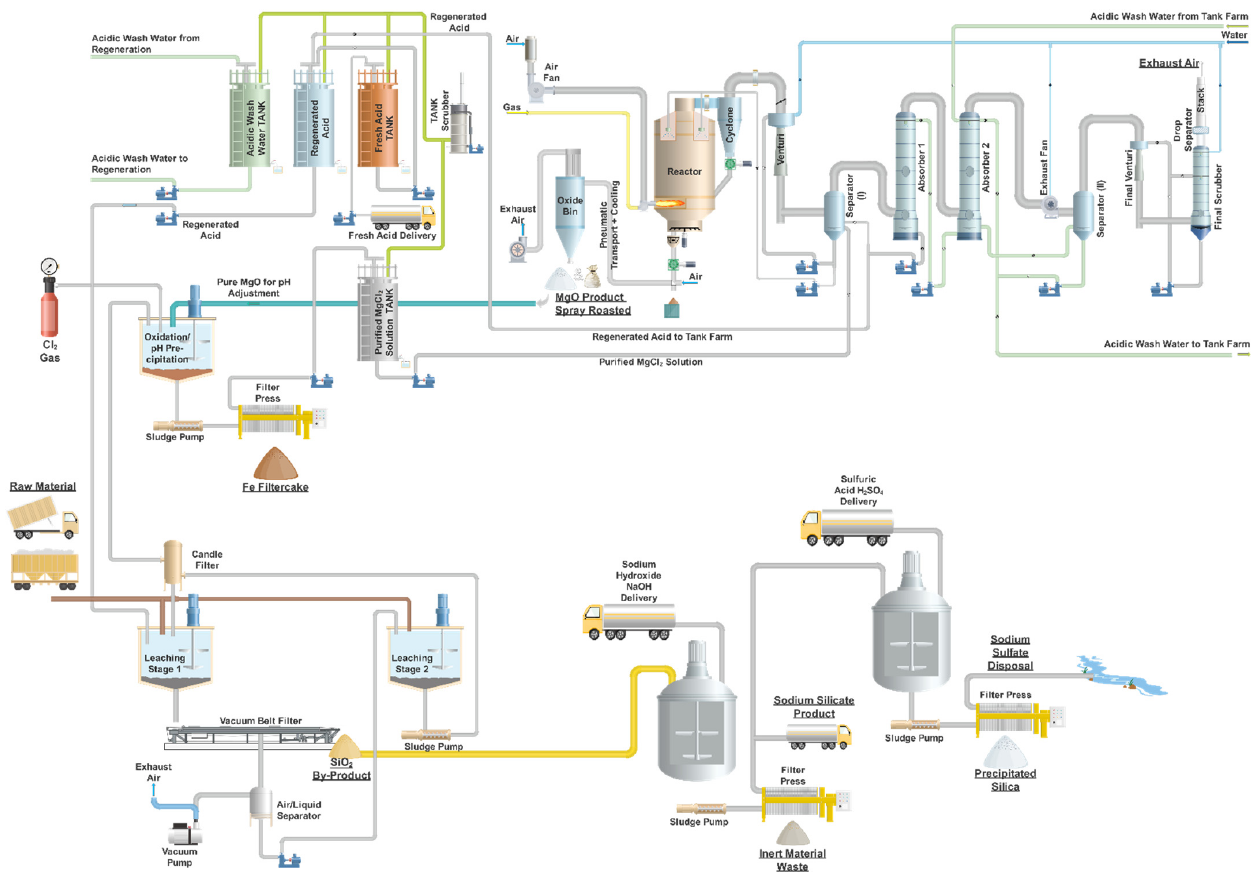
Figure 2. Industrial-style PFD showing the key process equipment used.